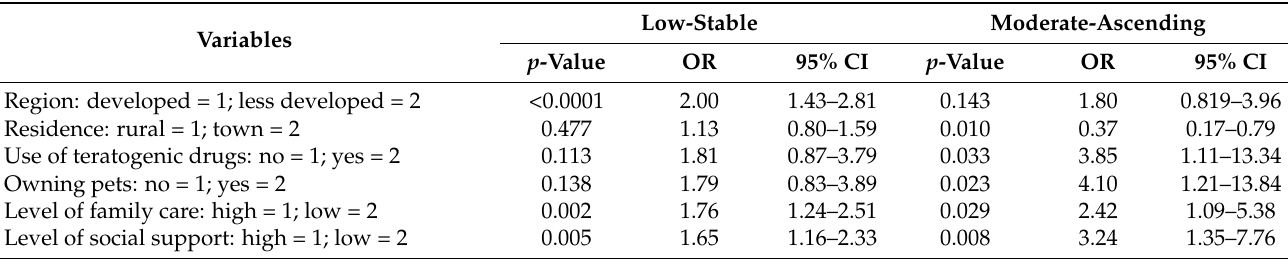
Table 6. Multinomial logistic regression analysis of anxiety trajectory groups.